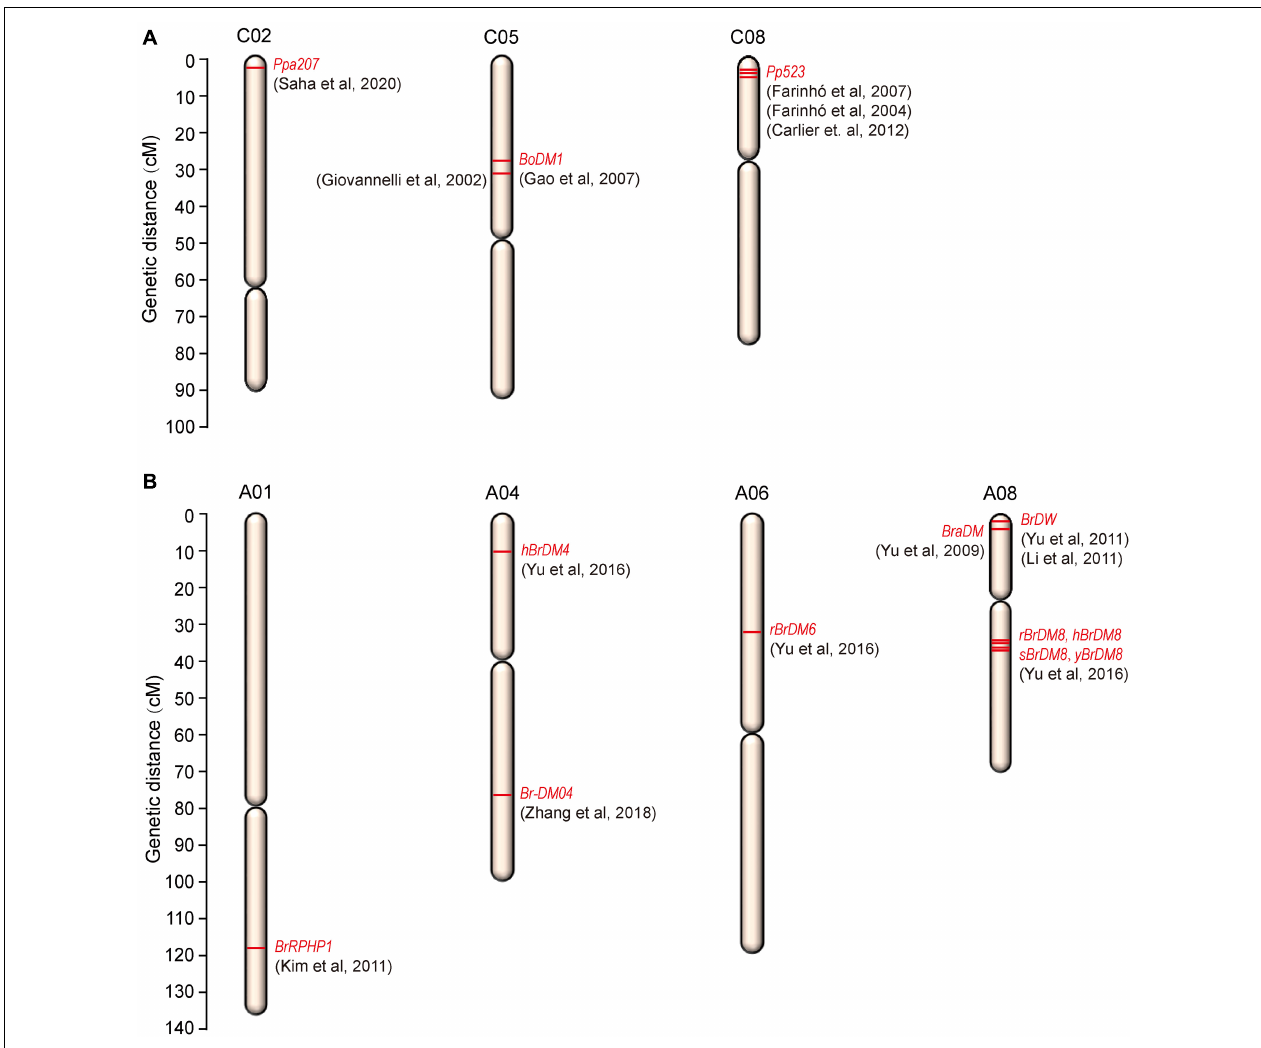
FIGURE 3 | Chromosomal locations of downy mildew resistance loci mapped on (A) B. oleracea and (B) B. rapa